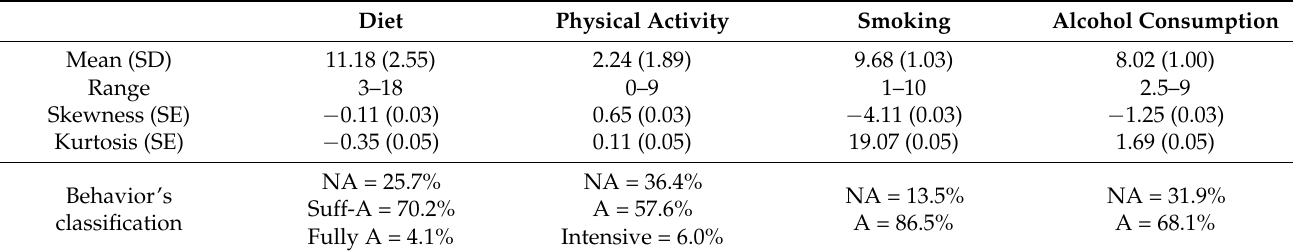
Table 2. Descriptive statistics of the four lifestyle